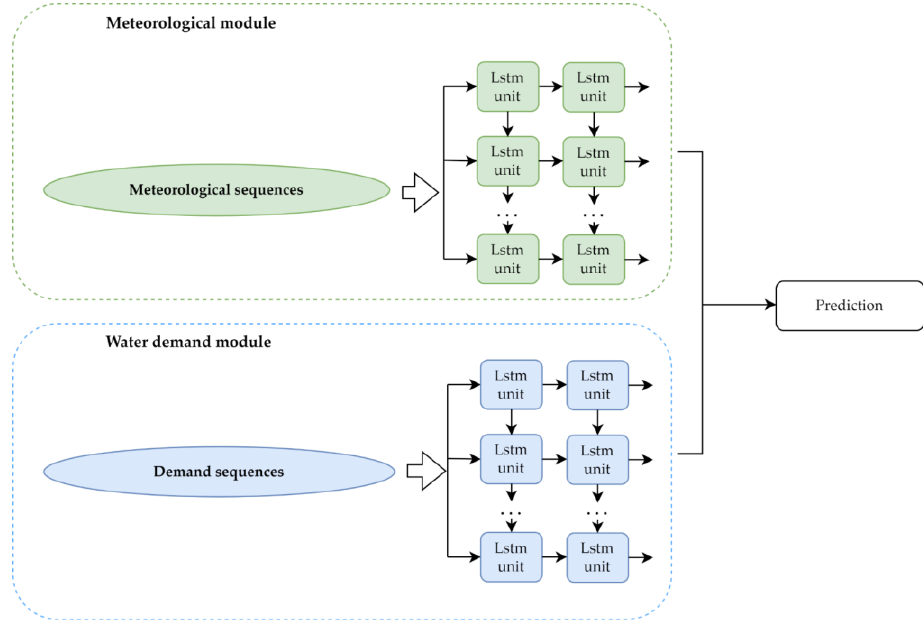
Figure 3. Diagram of the proposed medium-term forecasting model based on LSTM units.